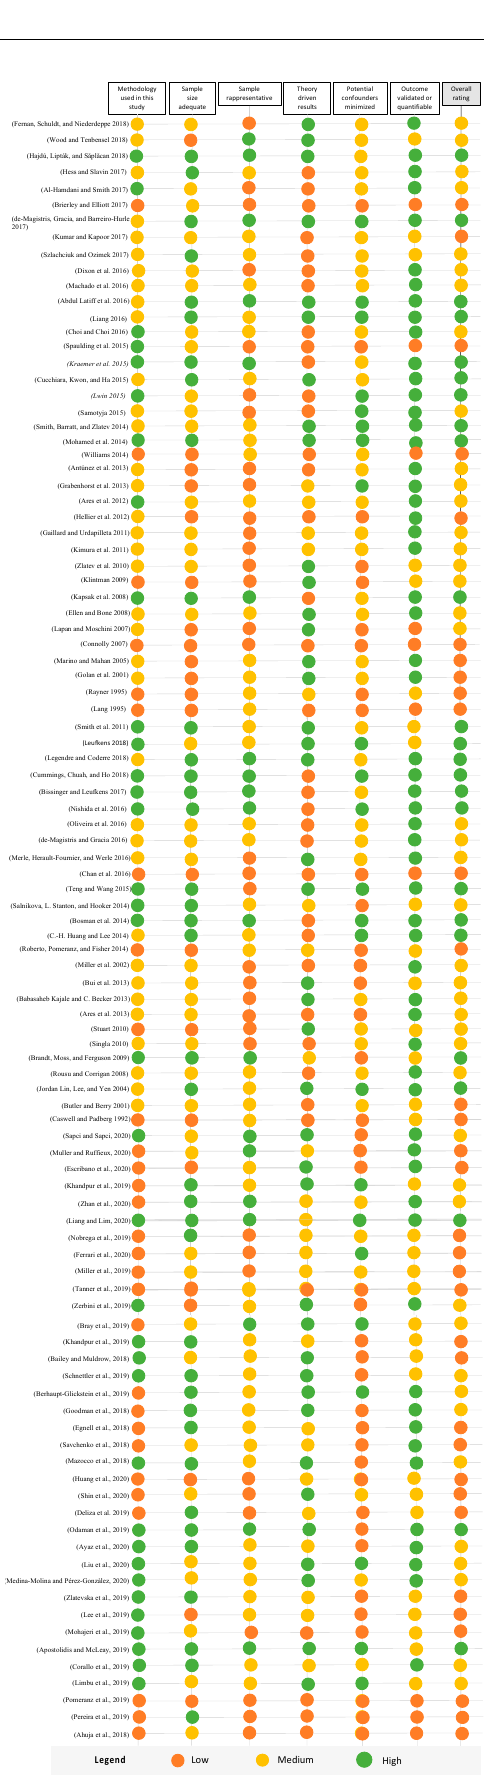
Figure 2. Quality assessment of